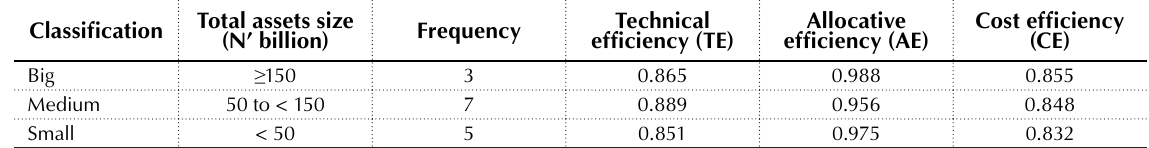
Table 3. Measured mean efficiency of the deposit money banks in 2003